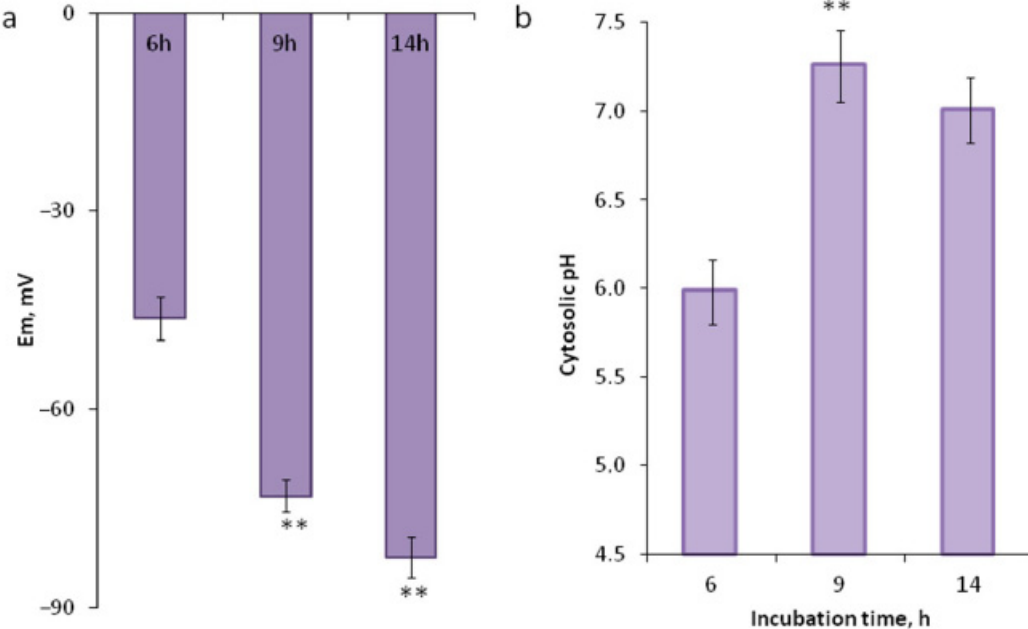
Figure 2. Dynamics of membrane potential and pH during pollen activation. ( a ) Plasma membrane hyperpolarization in the protrusion / tube assessed by DiBAC 4 (3) cytoplasmic staining. ( b ) Cytoplasm alkalization assessed by ratiometric BCECF-AM staining. Fluorescence was measured in the subapical area of the protrusion / tube. ** p < 0.01; * p < 0.05.